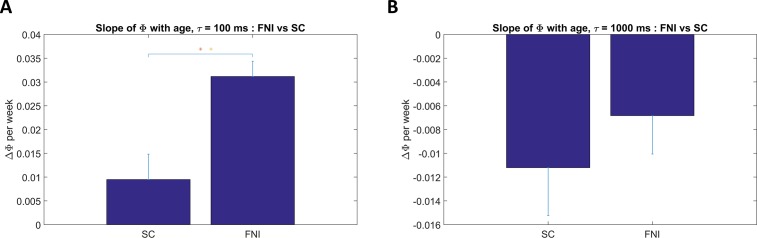
Slope of Φ during sleep.Two examples of group comparisons (FNI vs SC) using best-fit slopes of Φ with postmenstrual age, for the same two values of τ used in Fig 2. Results were pooled across sleep states (AS and QS). Significant differences (two sample t-tests) are denoted by single (p < 0.05) or double asterisks (p < 0.01). A: τ = 100 ms, B: τ = 1000 ms.